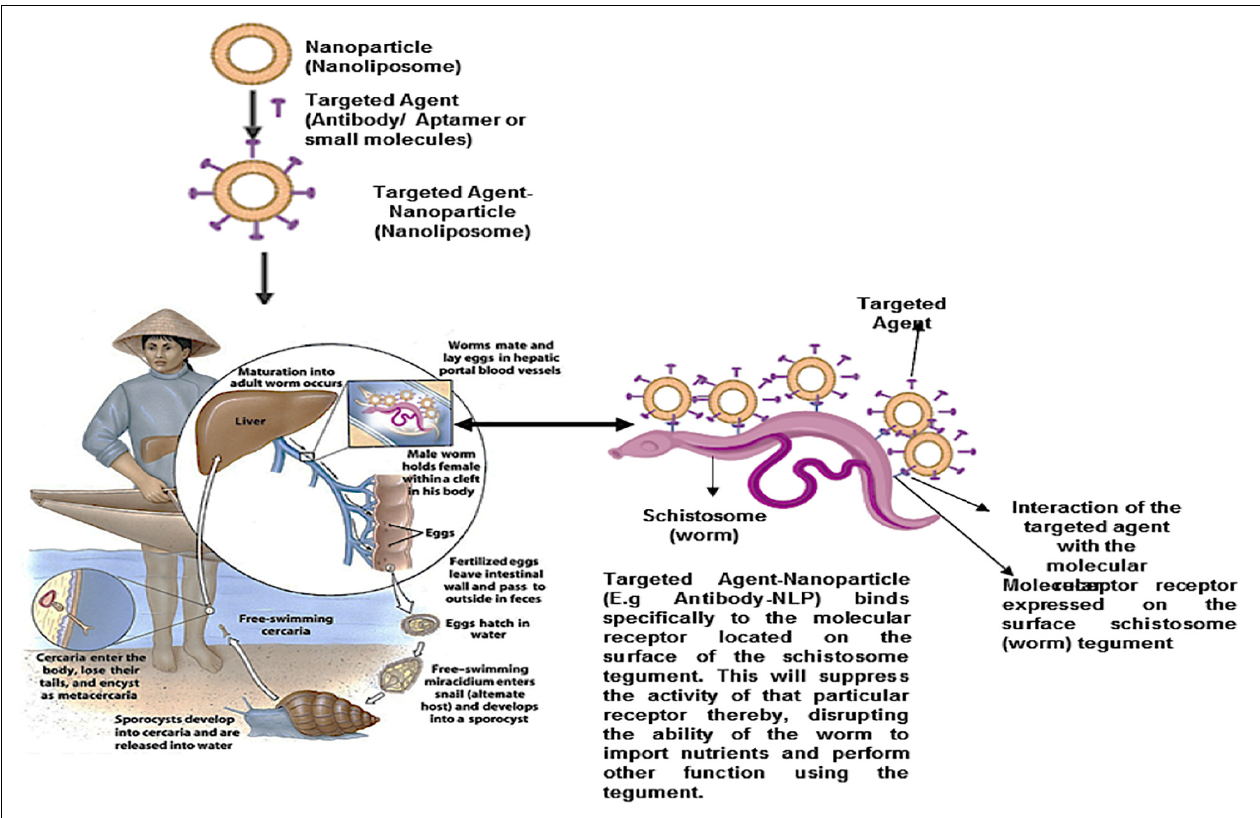
FIGURE 7 | Proposed schematic for nanoparticle (nanoliposome) surface engineered (functionalized) with targeted agents (Antibodies, aptamers, antibody-like ligands or small molecules). This targeted nanoparticle localized/detected as molecular receptors, located within the exterior of the schistosome tegument, and specifically binds to it. Thus, suppressing the activity of the receptor, as well as disrupt the ability of the worm to import nutrients from the host, and perform other